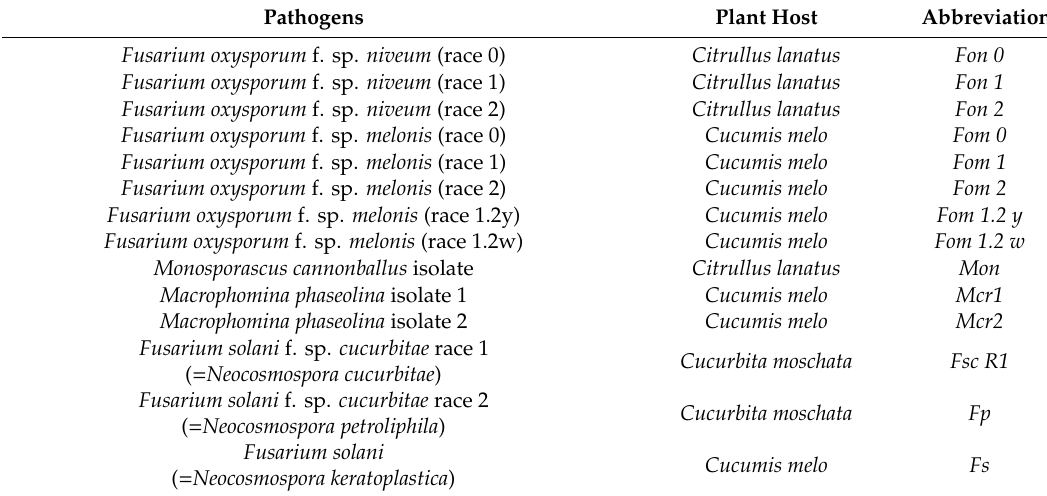
Table 1. Pathogenic isolates and potential microbial antagonists used in this study for their evaluation in dual plate